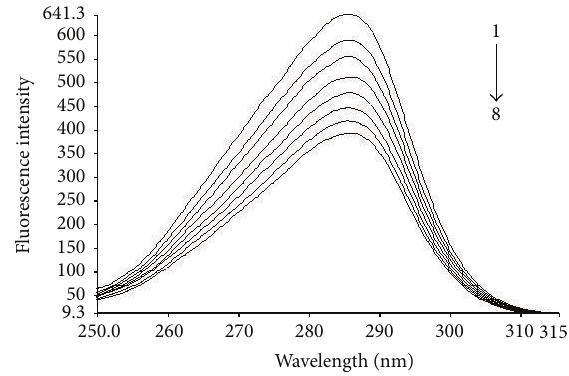
= 1 × 10 −6 M, 𝐶 ( Hyp ) = 0, 1, HSA )